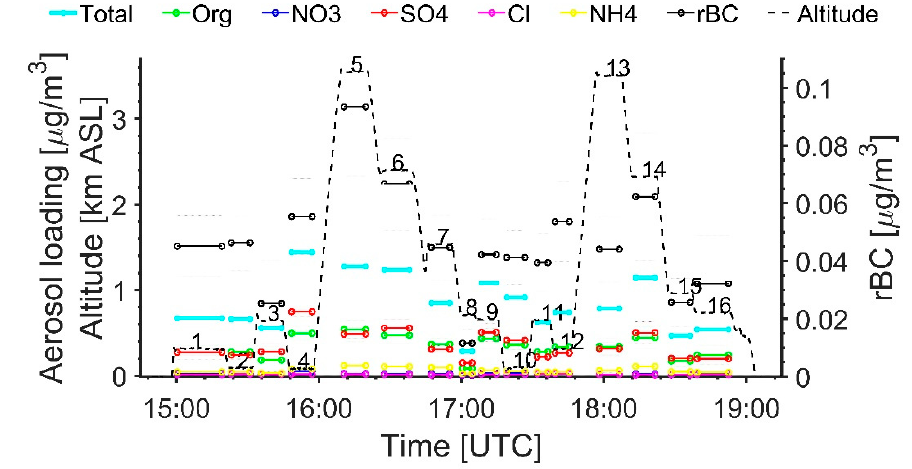
Figure 2. Example of FL-dependent chemical compositions (colored lines) and rBC (thick black lines) mass measured by the AMS and SP2, respectively (25 February 2013). Additionally, altitude (dotted black line) as a function of FL is included. FLs are labeled with numbers 1 through 16 on top of the dashed black altitude line.